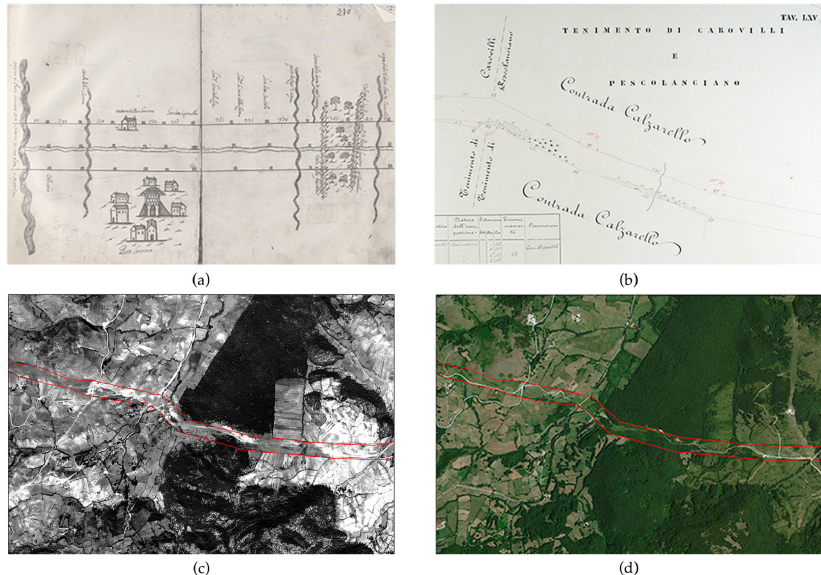
Figure 5. Comparison of the Tratturo Castel di Sangro-Lucera near the Vallone San Pietro (Municipalities of Carovilli and Pescolanciano—IS) among: ( a ) the Capecelatro’s Atlas Sheet 280 (Authorization to publish n. 5/2016, prot. 2915/28.34.01.10 del 14.10.2016 granted by the Director of Archivio di Stato di Foggia); ( b ) the Bonamici’s reinstatement table LXV (Authorization to publish n. 0004086/28.28.00/1 del 20.09.2016 granted by the Director of Archivio di Stato di Campobasso); ( c ) the orthophoto of 1954; ( d ) the aerial image of 2014.